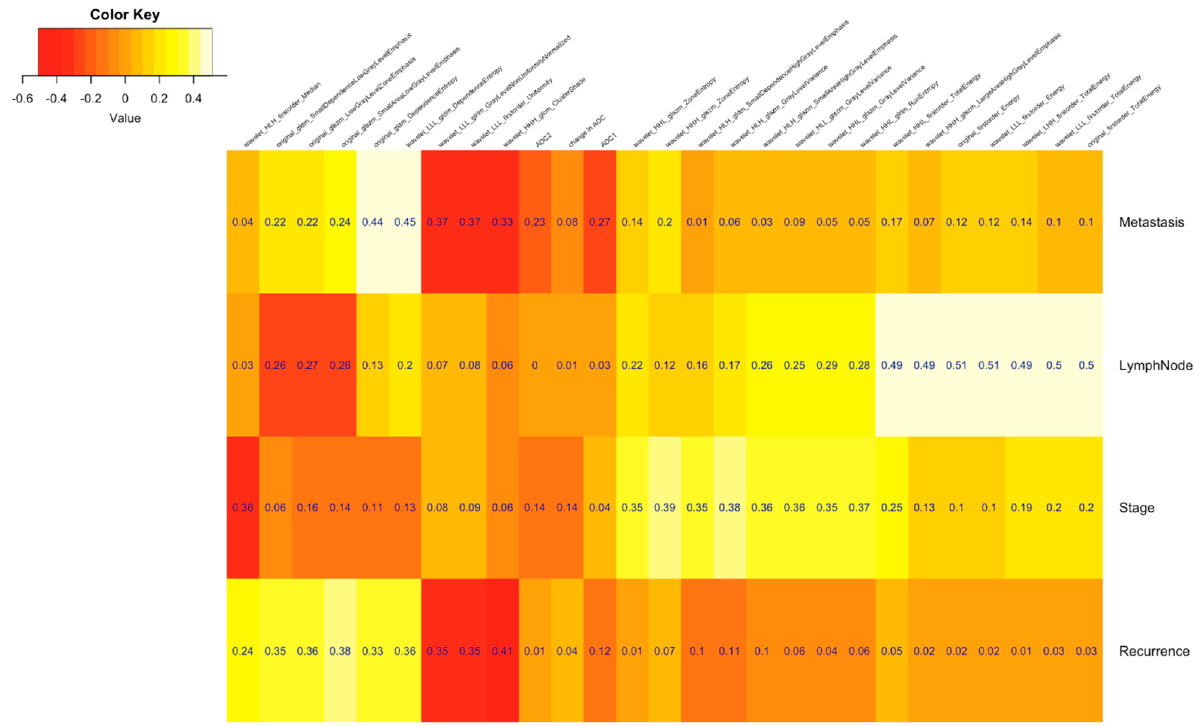
Figure 3. Heat map showing correlation between different radiomics and ADC features with the two classes of recurrence (absent and present).